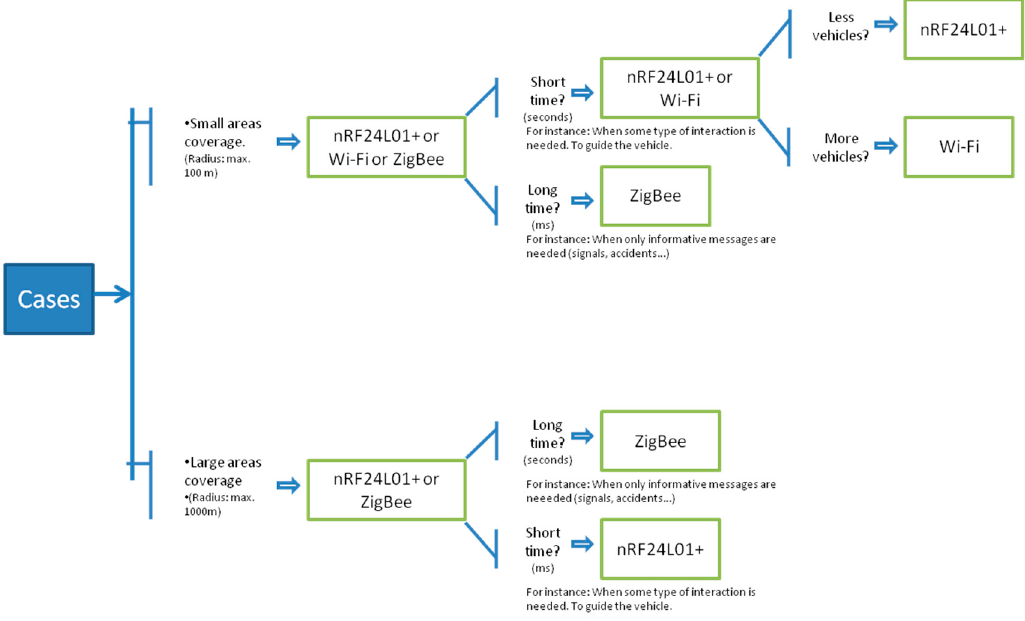
Figure 9. Device decision tree.